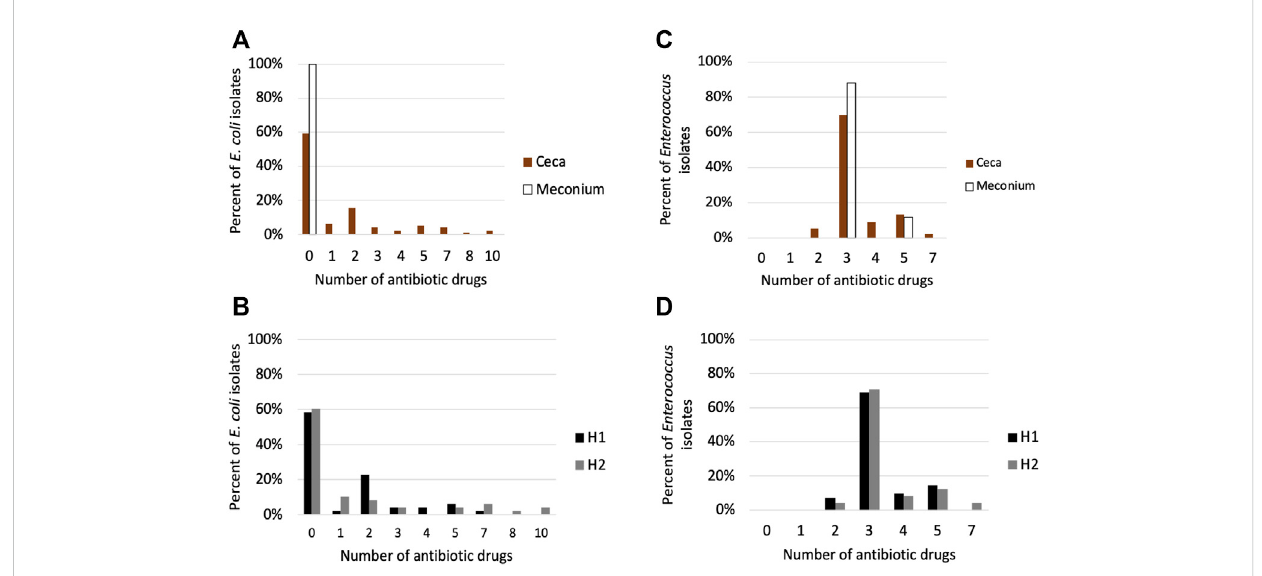
FIGURE 7 Antimicrobialsusceptibilitytestingof(E) coli and Enterococcu sisolates. (A) Percentageof E.coli isolates inthemeconium( n =25)andceca( n =96) thatareresistantto0 – 10antibiotics. (B) Percentageofcecal E.coli isolatesfromhouse1( n =48)andhouse2( n =48)thatareresistantto0 – 10antibiotic drugs (C) Percentage of Enterococcus isolates in the meconium ( n = 25) and ceca ( n = 90) that are resistant to 0 – 10 antibiotics (D) Percentage of cecal Enterococcus isolates from house 1 ( n = 42) and house 2 ( n = 48) that are resistant to 0 – 10 antibiotic